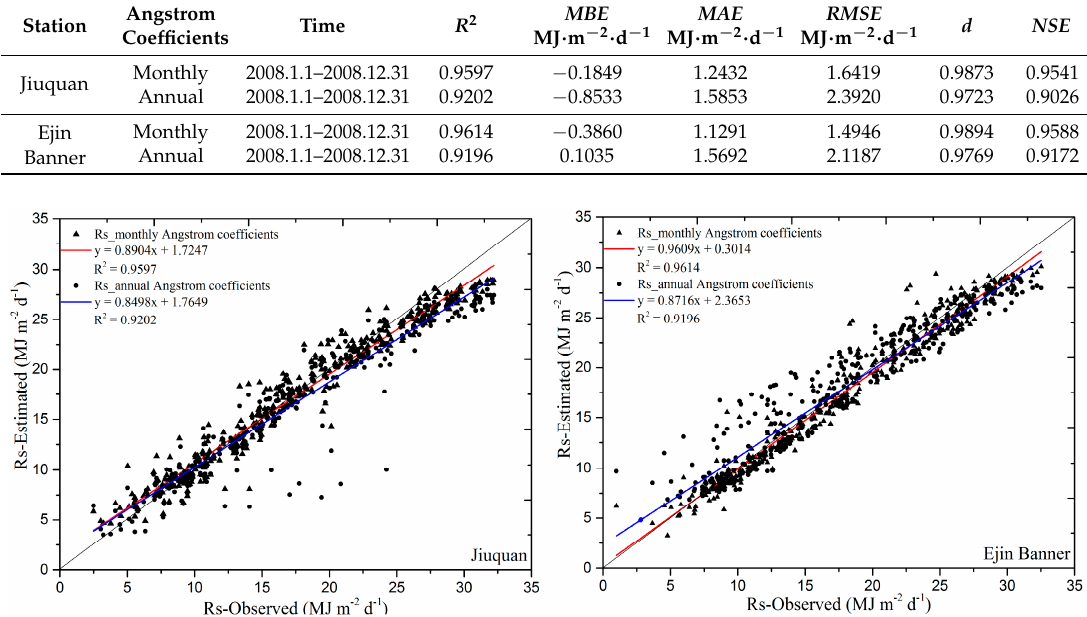
Figure 2. Comparison of the observed and estimated global daily solar radiation in 2008 (366 days) at Jiuquan ( left ) and Ejin Banner ( right ). Table 5. Statistics for the performance of the global daily solar radiation estimated by the proposed method at Jiuquan and Ejin Banner stations in 2008 (366 days).